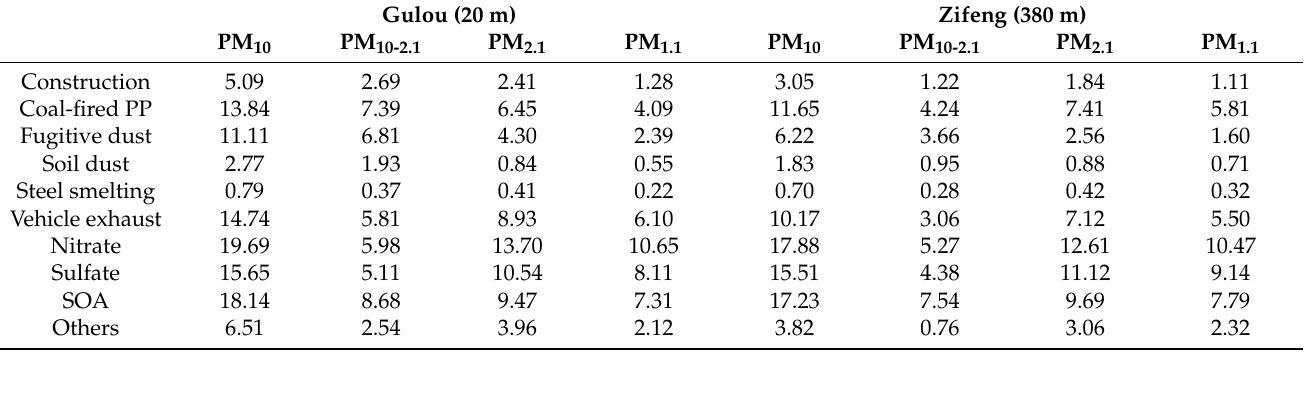
Table 5. Source contribution estimates (SCEs) of PM 10 , PM 10-2.1 , PM 2.1 , and PM 1.1 mass concentra- tions with CMB model ( µ g m − 3 ).